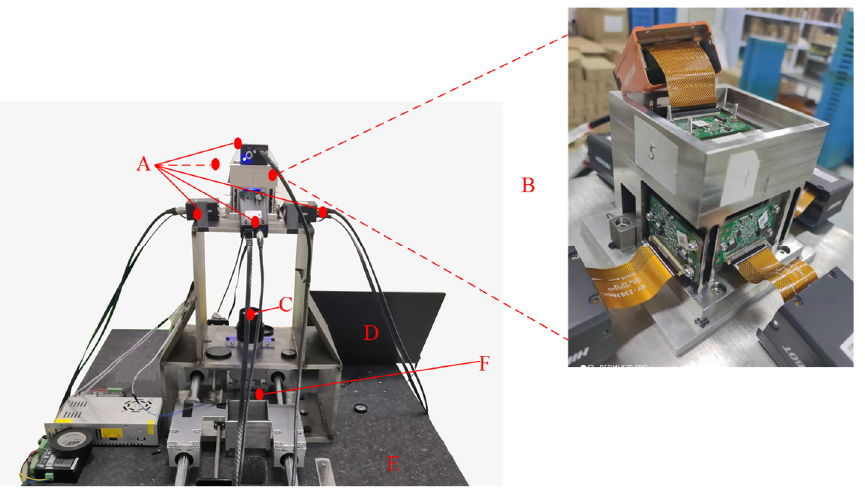
Figure 1. Actual picture of the test system. ( A ) Cameras; ( B ) prism s and cameras assembly; ( C ) cam- era lens; ( D ) computer; ( E ) marble slab; ( F ) photo-etching glass board and object to be